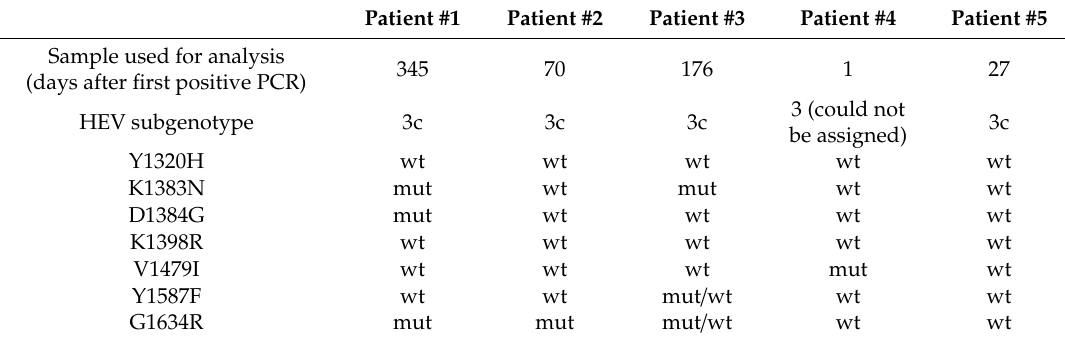
Table 4. HEV subgenotypes and potential RBV treatment failure-associated